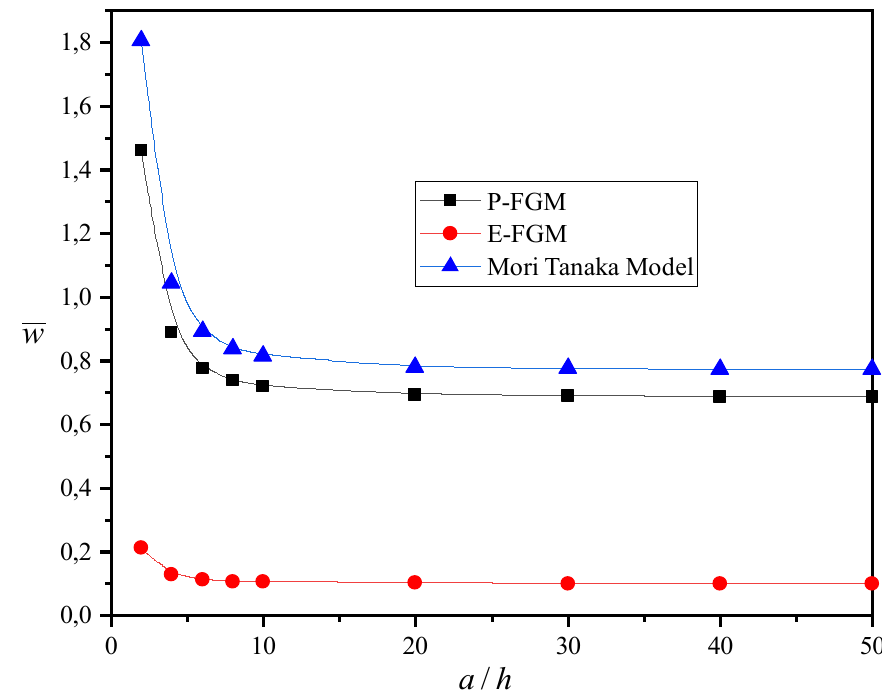
Figure 6. Effect of the side-to-thickness ratio ( a / h ) on the non-dimensional deflection of different FG plates.